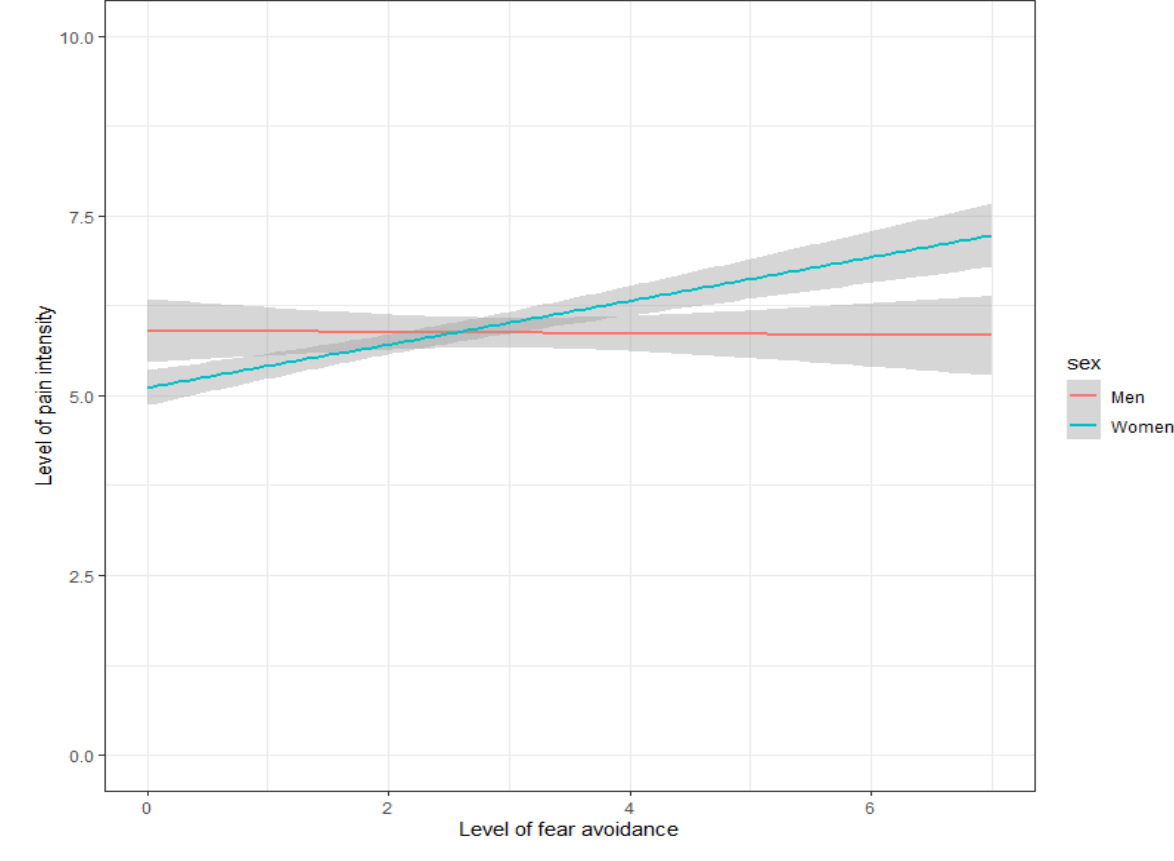
Figure 4. Visualization of the fluctuation of pain intensity, fear avoidance and affective experiences for men and women separately. Note: fear-avoidance and the affective experiences are measured